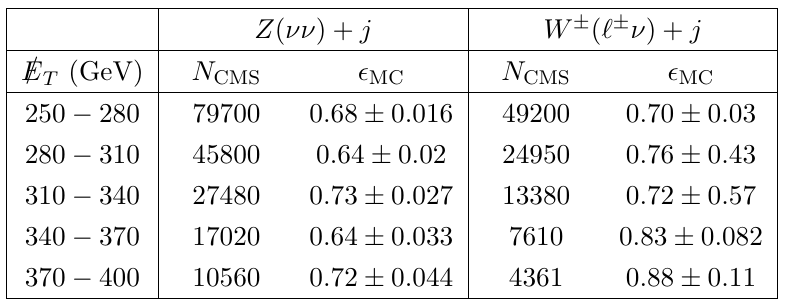
Table 3 . Number of events reported by CMS, N CMS , and ratio with the number of events from our simulation, (cid:15) MC . The reported uncertainties are statistical uncertainties from our